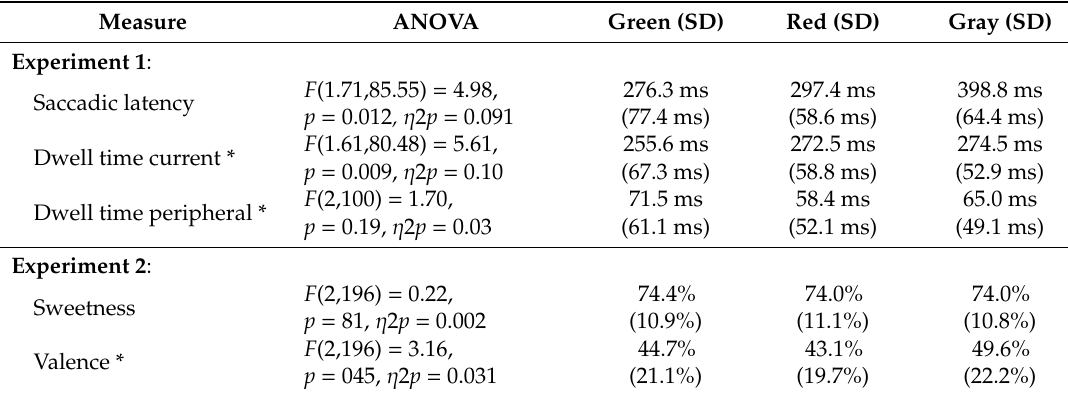
Table 2. Summary results of Experiments 1 and